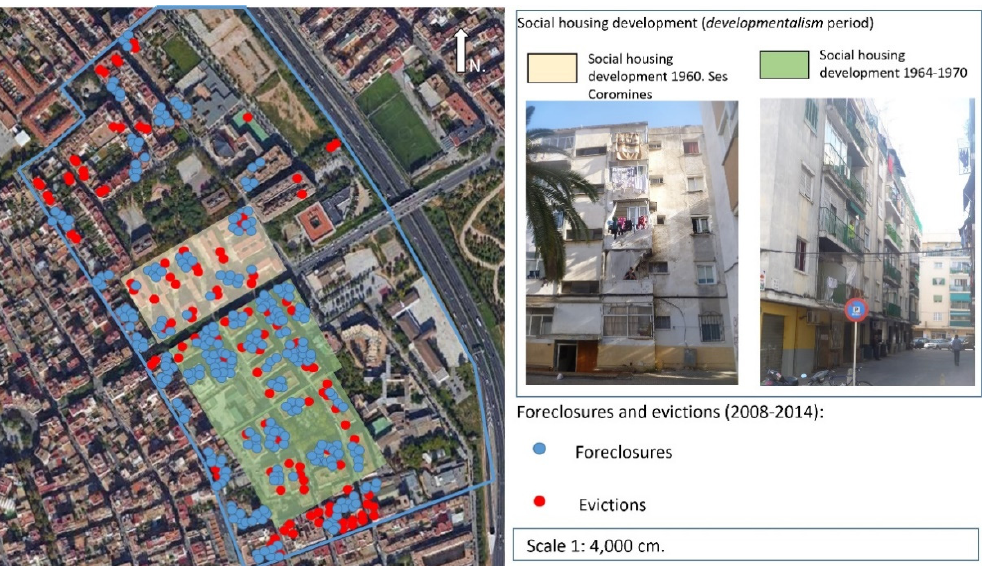
Figure 7. Typologies of social housing, evictions, and foreclosures in Son Gotleu